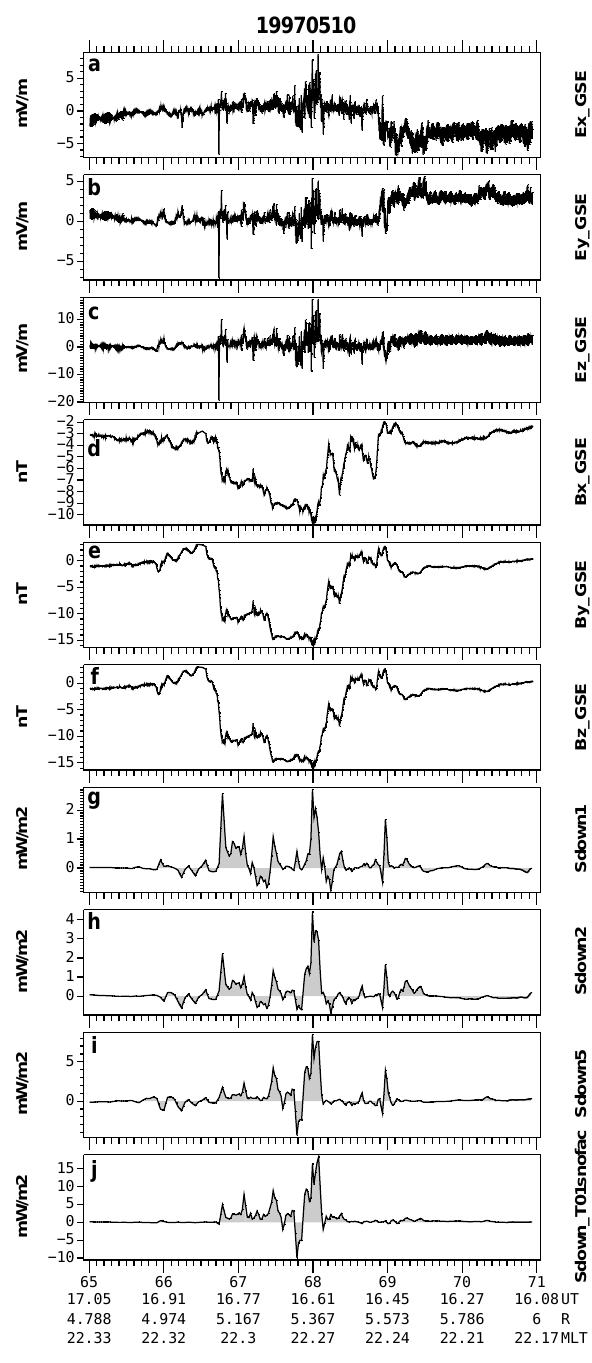
Fig. 1. Example event 10 May 1997. Cartesian GSE components of measured spin-plane EFI electric field (a − c) , GSE components of MFE magnetic field with T01s NOFAC background subtracted (d − f) , Fourier-filtered downward AC Poynting vector for iono- spheric scales less than 100km, 200km, 500km ( (g − i) , respec- tively) and total downward DC Poynting vector with T01s NOFAC model subtraction (j)